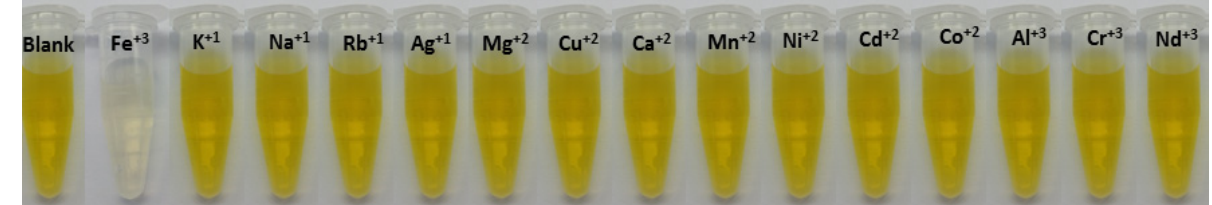
Figure 11. Photograph of the fresh solutions containing mixtures of functionalized Ag-PTA nanocomposites with different metal cations. The ion concentrations of Na + , K + , Rb + , Ag + , Mg 2+ , Cu 2+ , Ca 2+ , Mn 2+ , Ni 2+ , Cd 2+ , Co 2+ , Al 3+ , Cr 3+ , and Nd 3+ were each 100 μ M. The concentration of Fe 3+ was 20 μ M.